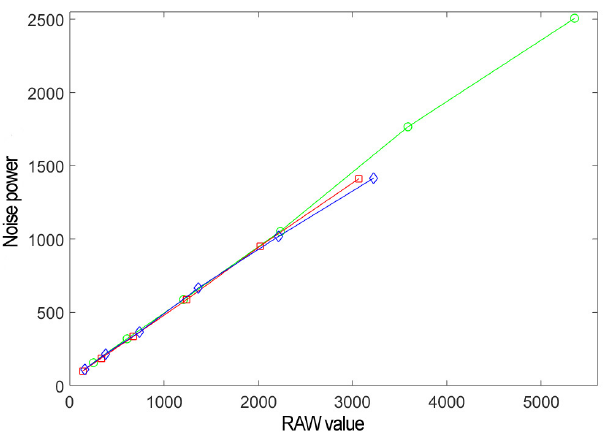
Figure 1. Noise power N 2 vs. Signal S for a Canon 50D with ISO = 100. Red squares, red channel; green circles, green G1 channel; blue triangles, blue